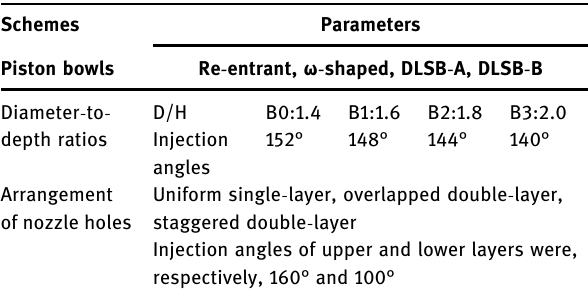
Table 4: Parameters of simulation schemes Schemes Parameters